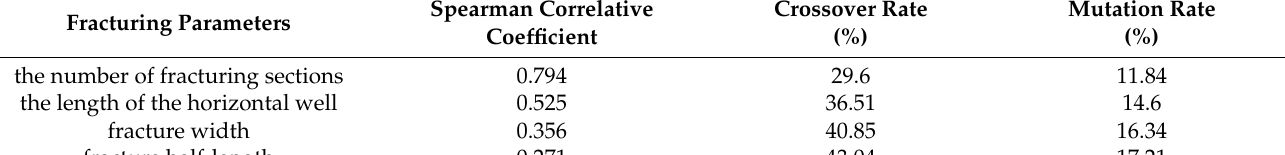
Table 4. The mutation and crossover rates of each fracture parameter.